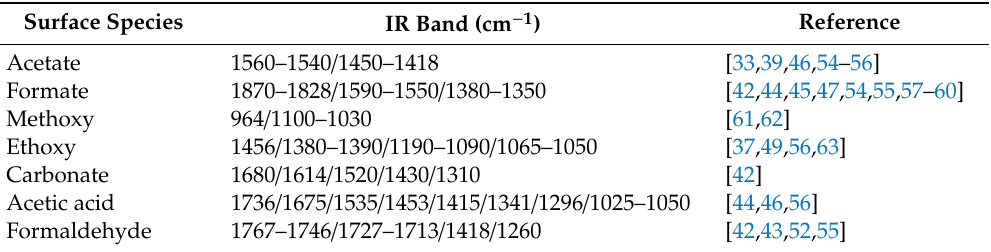
Table 3. Infrared (IR) bands assignment of the major surface species formed during the PDC process, in the 2000–950 cm − 1